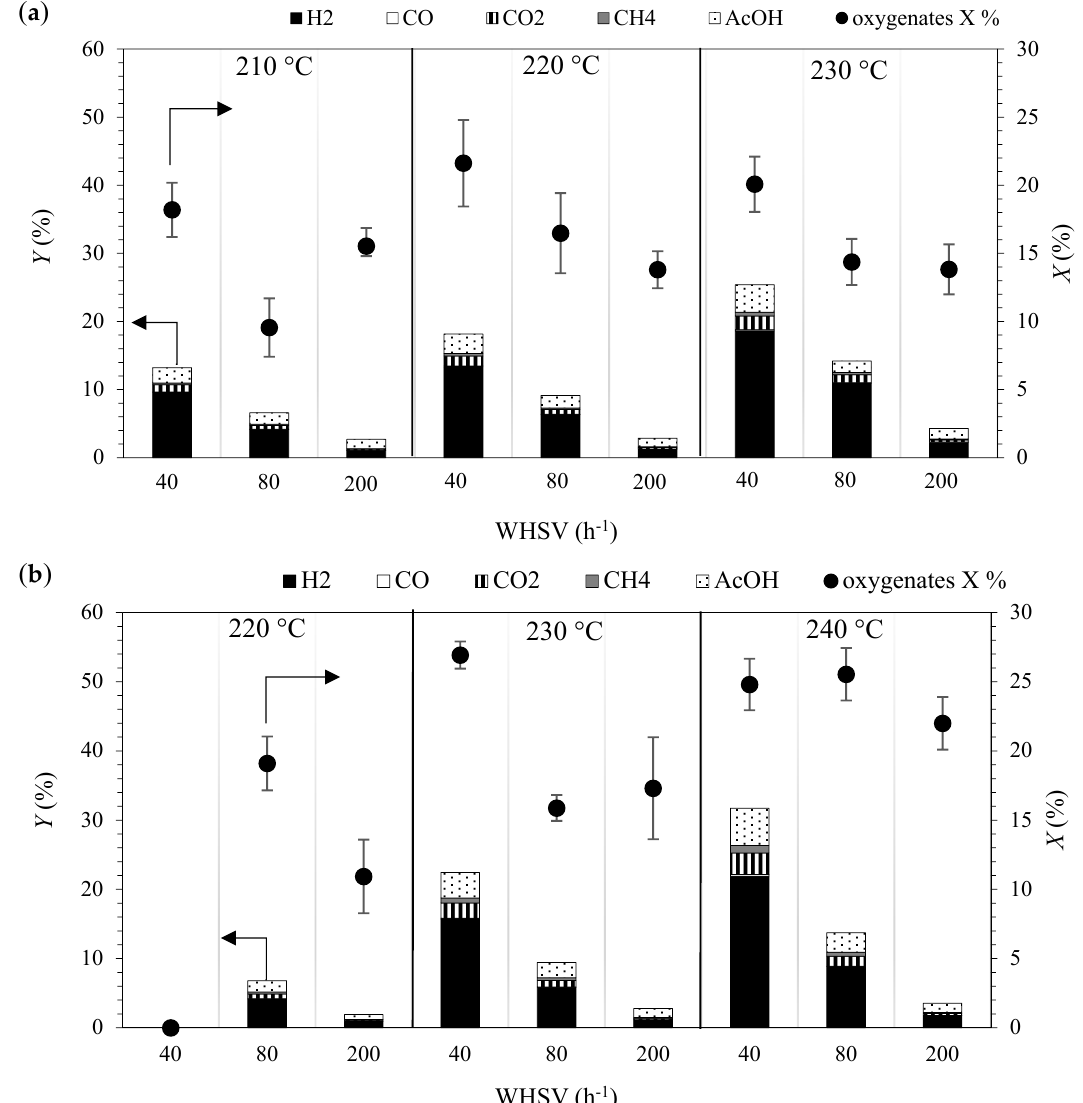
Figure 1. (Weight based) total conversion of oxygenates (dots) and (mole based) yield (columns) of hydrogen (black), carbon monoxide (white), carbon dioxide (vertical lines), methane (grey) and acetic acid (white with dots) in the aqueous-phase reforming (APR) Fischer–Tropsch (FT) water over NiCu/25CeZr at 3.2 ( a ) and 4.5 MPa ( b ). The total conversion of oxygenates includes standard deviation, whose values were obtained from three analysis of the same sample.